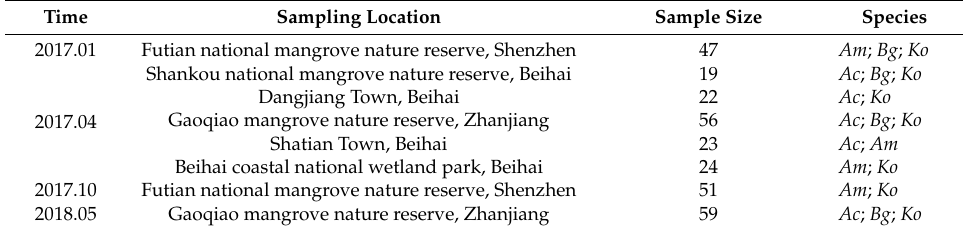
Figure 1. The distribution and location of study areas. Table 1. Statistics of 301 mangrove leaf samples.